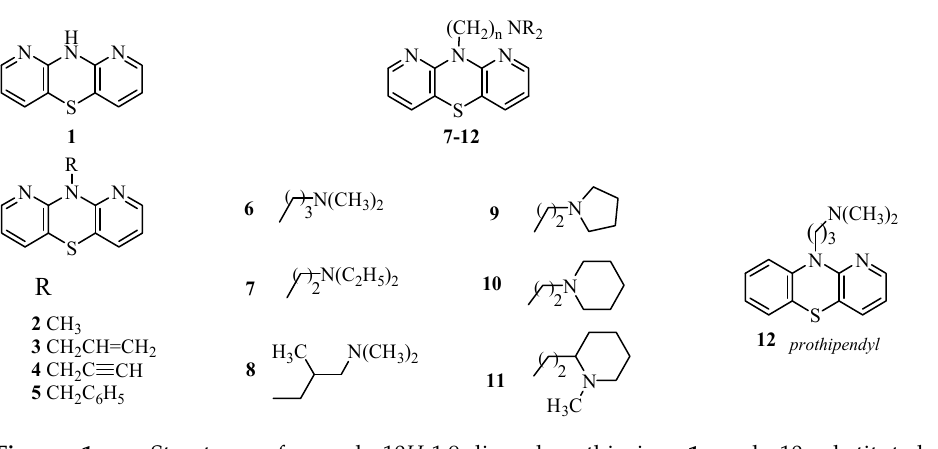
Figure 1. Structure of novel 10 H -1,9-diazaphenothiazine 1 and 10-substituted 1,9-diazaphenothia- zines 2 – 11 and reference compound prothipendyl 12